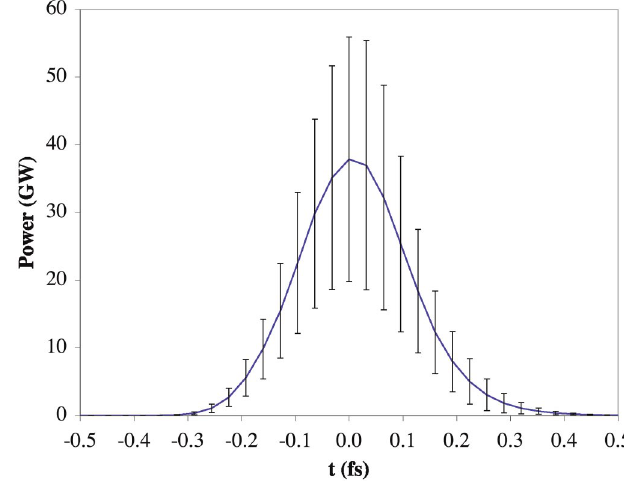
FIG. 8. (Color) Expected x-ray energy produced from various sources (the central current peak, the side peaks, and the back- ground) as a function of distance along the undulator. Variations in energy due to shot noise are indicated by the error